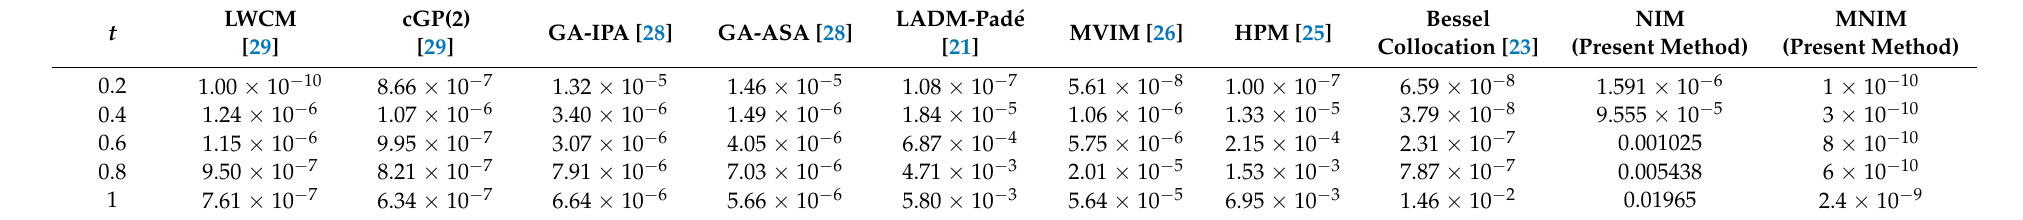
Table 4. Comparison of Absolute Errors for Z ( t ) of MNIM Scheme and LWCM, cGP(2), GA-IPA, GA-ASA, LADM-Pad é , MVIM, HPM, Bessel collocation, NIM relative to RK4 Method for HIV Infection